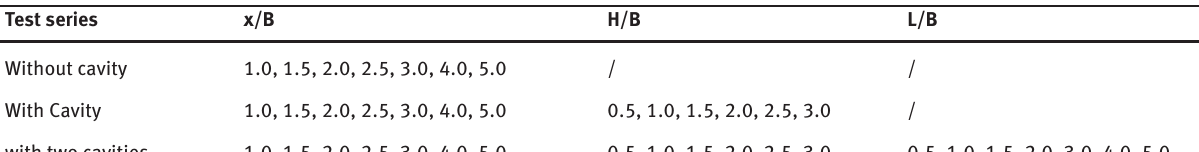
Table 2: Model tests program. Test series